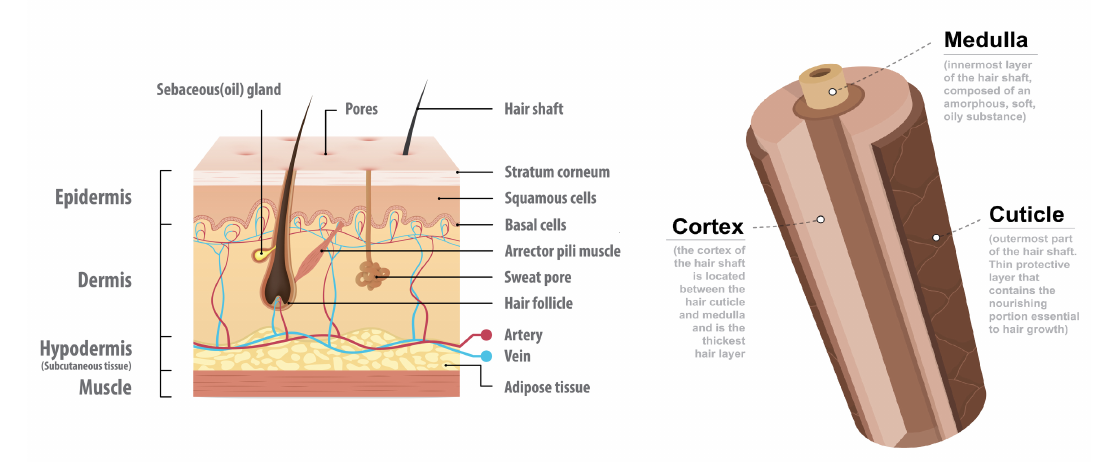
Figure 1. Human skin [5] and hair anatomy